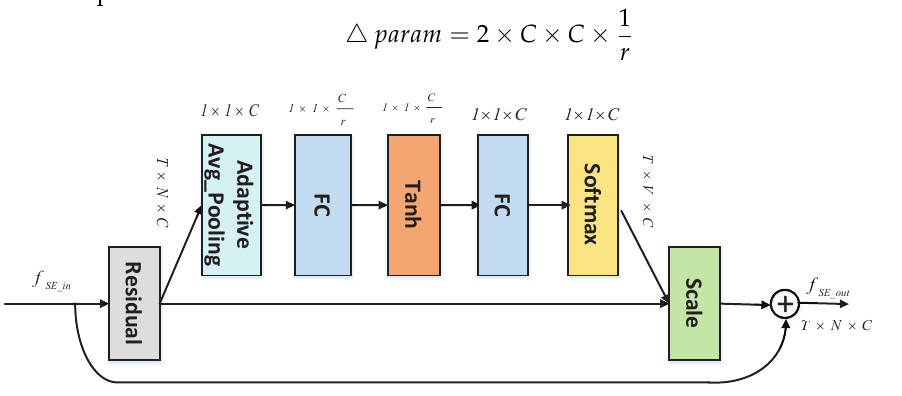
Figure 3. SE block.